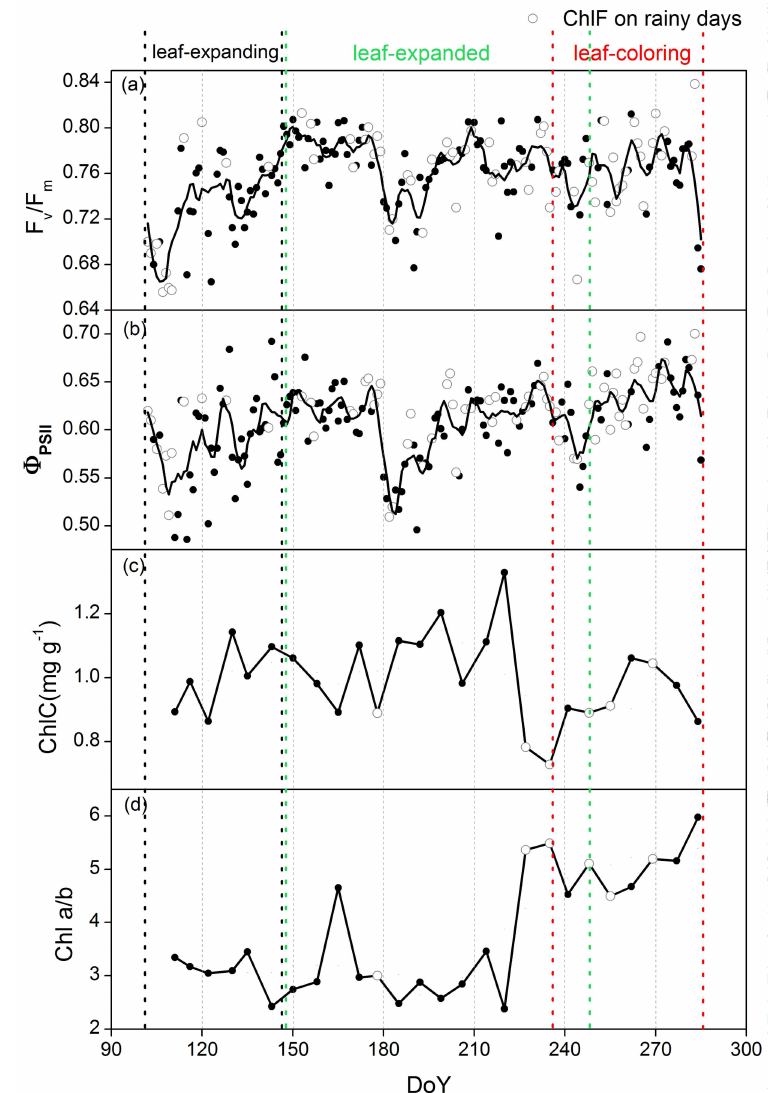
Figure 2. Time series of ChlF-associated parameters, i.e., maximal quantum yield of PSII photochemistry (F v /F m , ( a )), daily mean effective quantum yield of PSII photochemistry ( Φ PSII , ( b )), sum content of chlorophyll a and b (ChlC, ( c )), and ratio of chlorophyll a to chlorophyll b (Chl a/b, ( d )) during the growing season (DOY 102 to 285) of 2014. Open circles represent ChlF-associated parameter values during rainy days. Major trend lines for F v /F m and Φ PSII were modified according to the Savitzky-Golay method. Black, green, and red vertically dotted lines represent leaf-expanding, expanded, and coloring